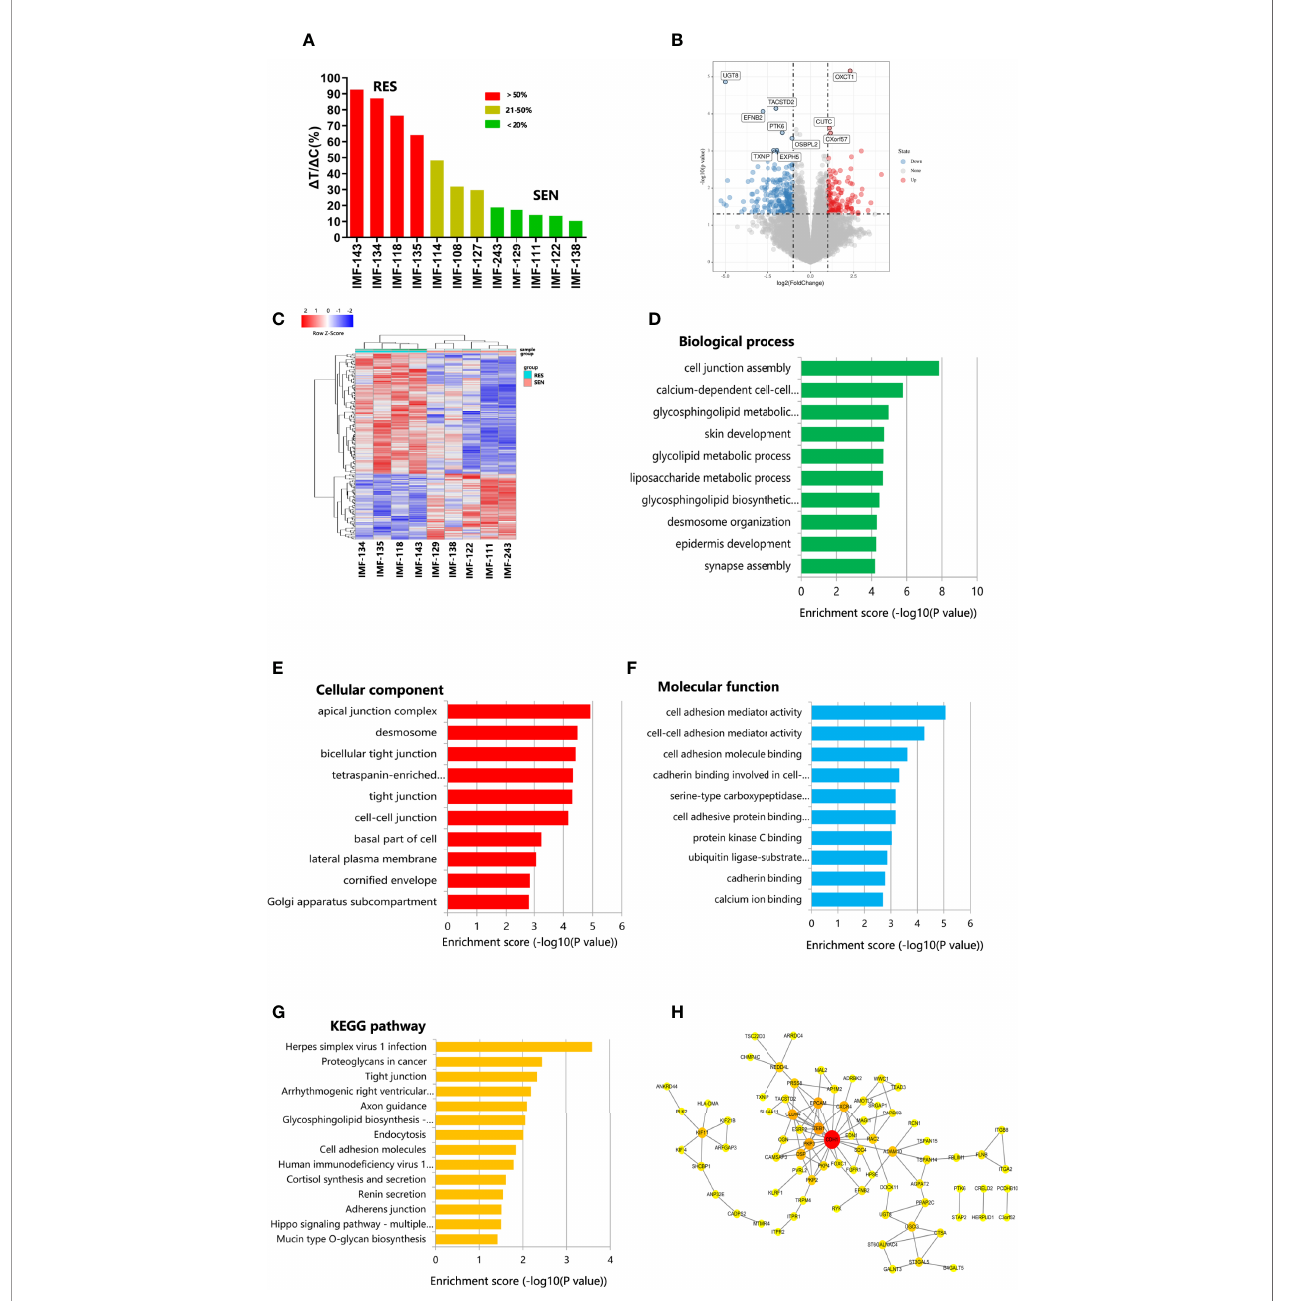
FIGURE 5 | PDX models revealed potential mechanism of lenvatinib resistance. (A) Waterfall plot of lenvatinib response after 4 weeks of treatment in 12 cases. Resistant, stable and sensitive cases are shaded in red, yellow and green, respectively. RES, resistant; SEN, sensitive; (B) Volcano plot represents signi fi cantly differentially expressed genes in lenvatinib-sensitive group and lenvatinib-resistant. Selected top up- and downregulated genes are labeled; (C) Heat map of differentially expressed gene between lenvatinib-sensitive and lenvatinib-resistant PDXs. (D – F) GO analysis of differentially expressed gene according to biological process, cellular component and molecular function, respectively; (G) Pathway analysis based on the KEGG database; (H) Protein – protein interaction (PPI) networks for differentially expressed proteins. The gene network was constructed using Cytoscape software based on the STRING